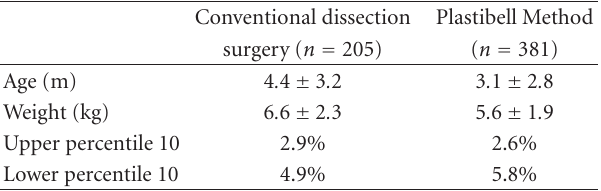
Table 1: Demographic characteristics of